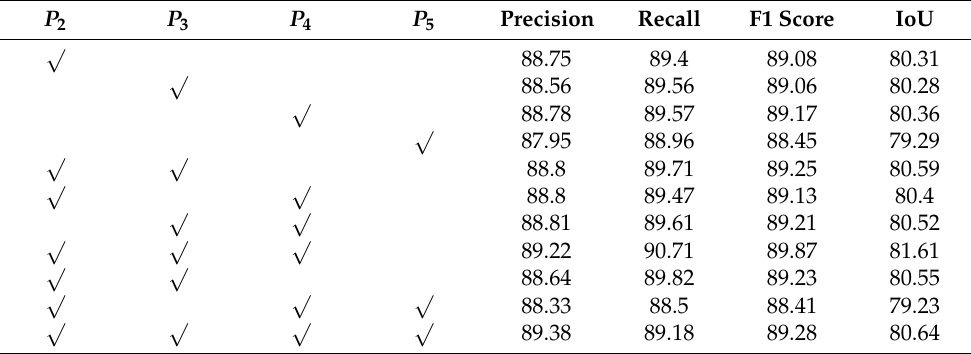
Table 4. Distillation using different combinations of